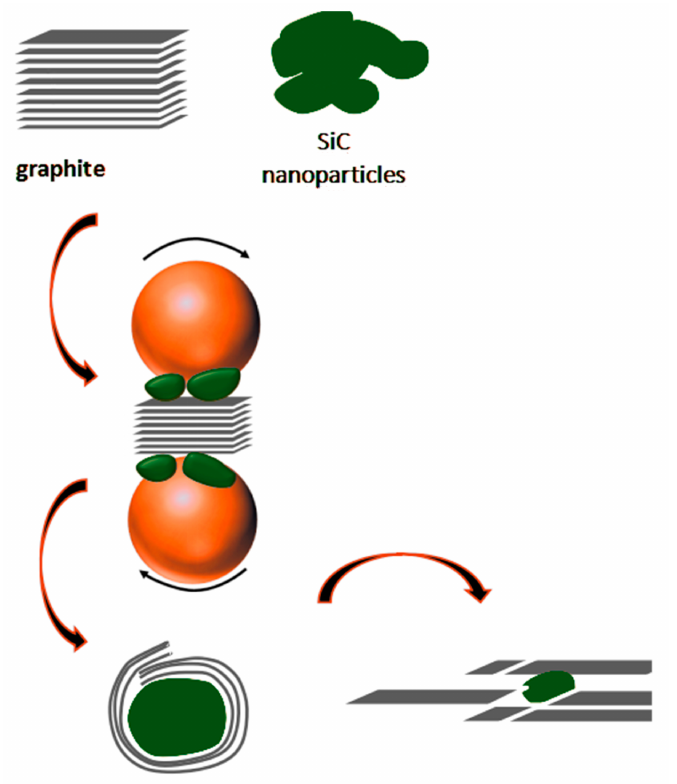
Figure 1. 1. Figure 9. Schematic diagram of wrapping method of graphene on SiC